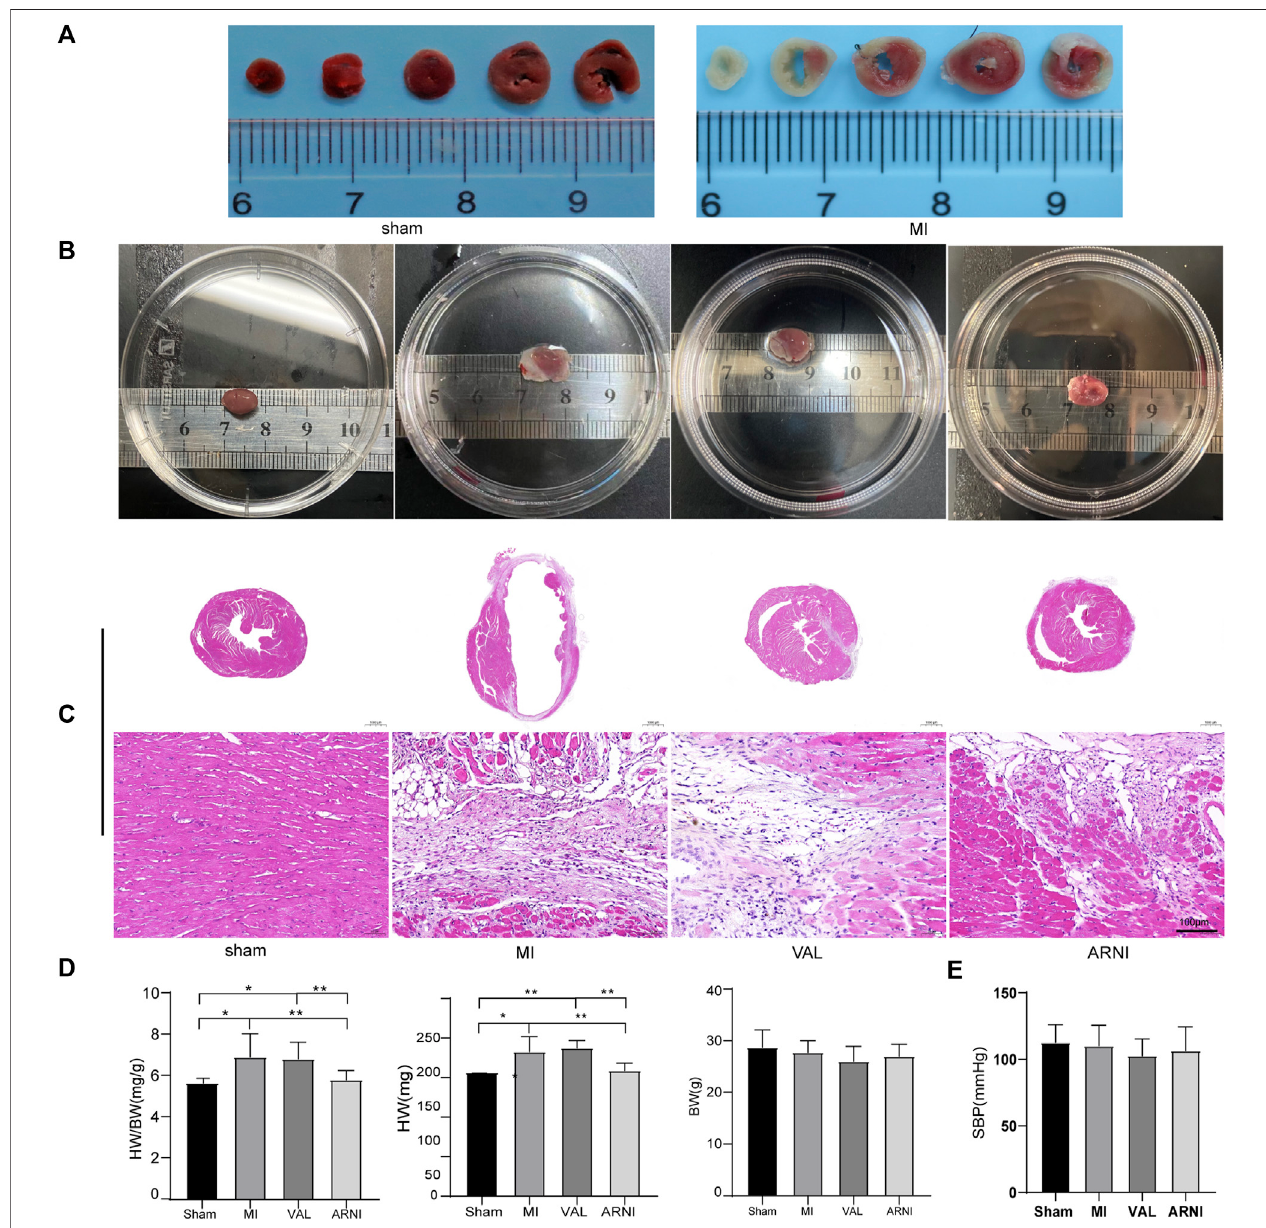
FIGURE1| TTCstaining,heartsize,andpathologyinthefourgroupsofmice. (A) TTCstaining. (B) Theheartgrossmorphologicalimage. (C) H&EstainingofCross- sections oftheheartsat thepapillarymuscle level and theinfarctsection (scale bar:100 μ m). (D) Quantitative analysisofthe heart weight to body weight (HW/BW) ratio. (E) SBP-systolic blood pressure. Sham: sham-operated group; MI: myocardial infarction; VAL: valsartan intervention group; ARNI: Sacubitril/valsartan intervention group. Each group n (cid:1) 7. * p < 0.01,** p < 0.05.